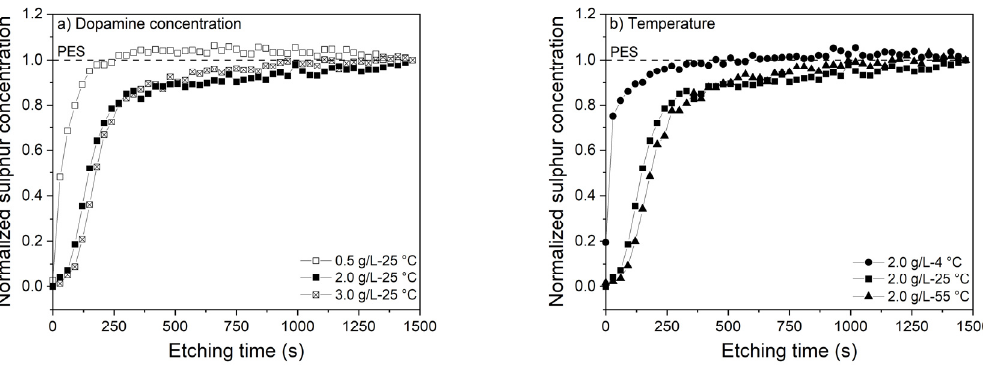
Figure 5. Normalized sulfur profiles of the membranes coated with different ( a ) dopamine concentrations at 25 °C (0.5, 2.0, and 3.0 g/L) and ( b ) temperatures (4, 25, and 55 °C).